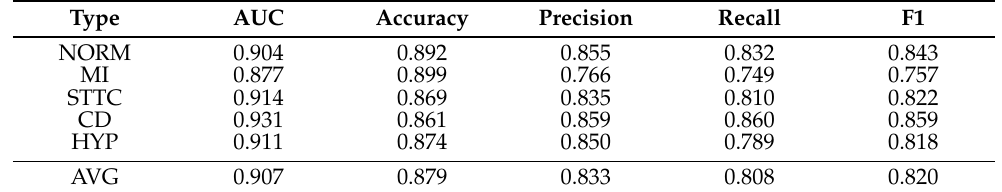
Table 10. Results produced by the proposed model without the Bi-GRU module on the PTB-XL dataset. Type AUC Accuracy Precision Recall F1 NORM